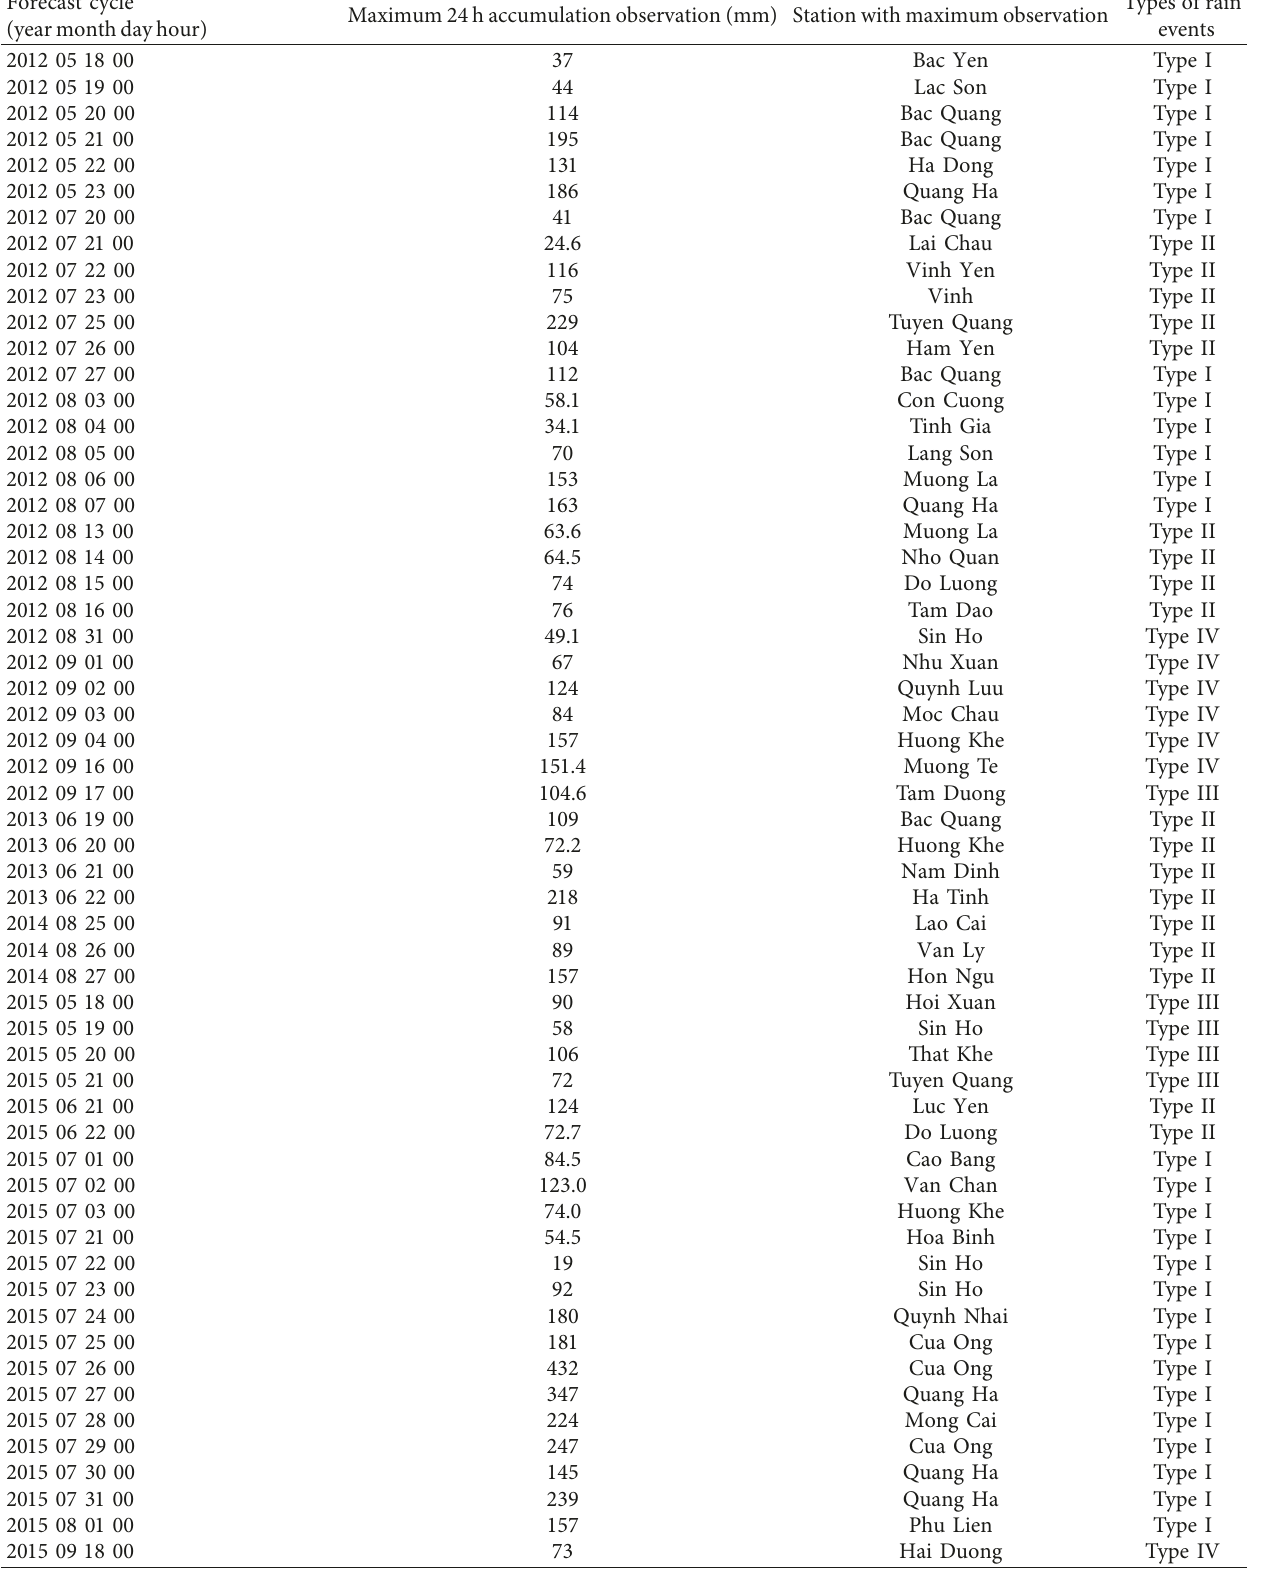
Table 3: List of forecast cycles related to heavy rain cases from 2012 to 2016, the station with maximum daily accumulated rainfall up to 72h for each cycle, and types of main synoptic situations. Forecast